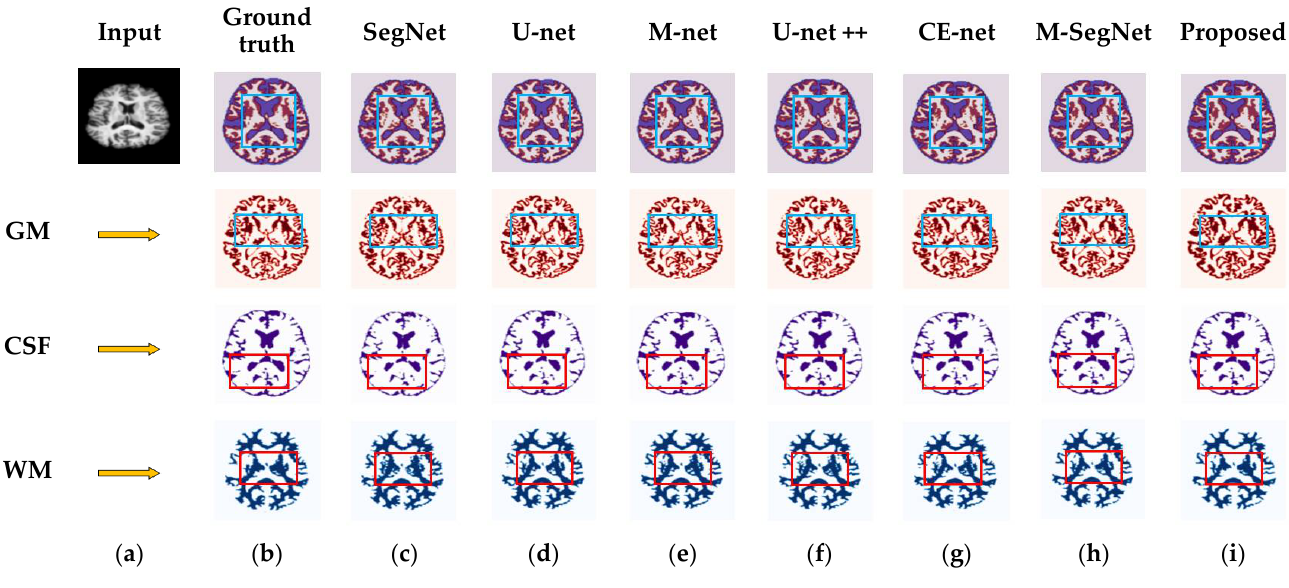
Figure 6. Qualitative comparison for GM, CSF, and WM using the proposed method and existing methods for the OASIS dataset. From left to right: ( a ) original input image; ( b ) ground-truth map; ( c ) segmentation results obtained by SegNet; ( d ) segmentation results obtained by U-net; ( e ) seg- mentation results obtained by M-net; ( f ) segmentation results obtained by U-net++; ( g ) segmentation results obtained by CE-Net; ( h ) segmentation results obtained by M-SegNet; ( i ) segmentation results obtained of the proposed SM-SegNet.